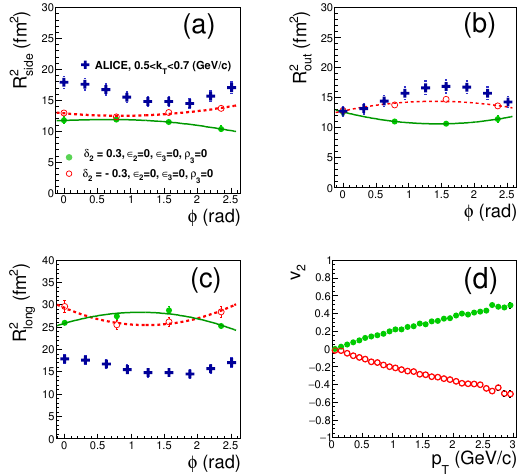
Figure 1. ( a – c ) The azimuthal dependence of R 2 in the HYDrodynamics with JETs (HYDJET++) calculations of Pb + Pb collisions at with the centrality 20–30%. The k T range is 0.2–2.0 GeV/ c . ( d ) The differential elliptic flow of charged hadrons as a function of p T . The distributions show calculations with ε 2 = 0.3 (solid circles) and with ε 2 = − 0.3 (open circles). ALICE data from [13] for 0.5 < k T < 0.7 GeV/ c are shown by crosses. Lines are drawn to guide the eye.